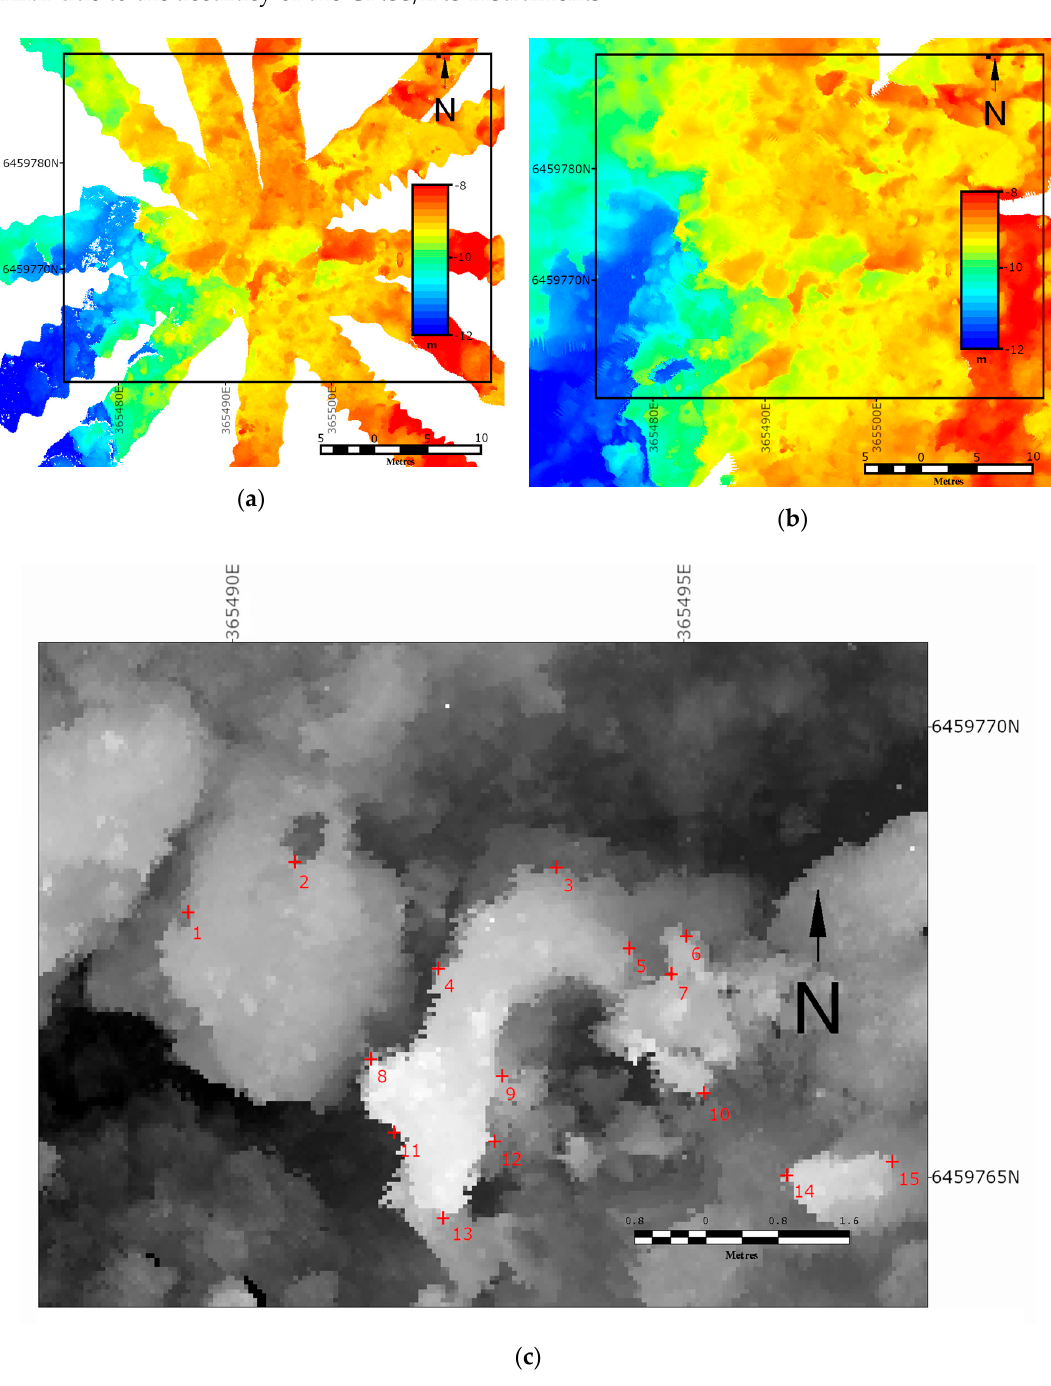
Figure 10. Underwater 16-point star dataset with the raw trajectory projection for ( a ) LiDAR and ( b ) MBES. ( c ) Control points used to assess the effectiveness of simultaneous localisation and mapping (SLAM). Background is nominal LiDAR depth, shown in grey scale to highlight the control points (SUTM50).